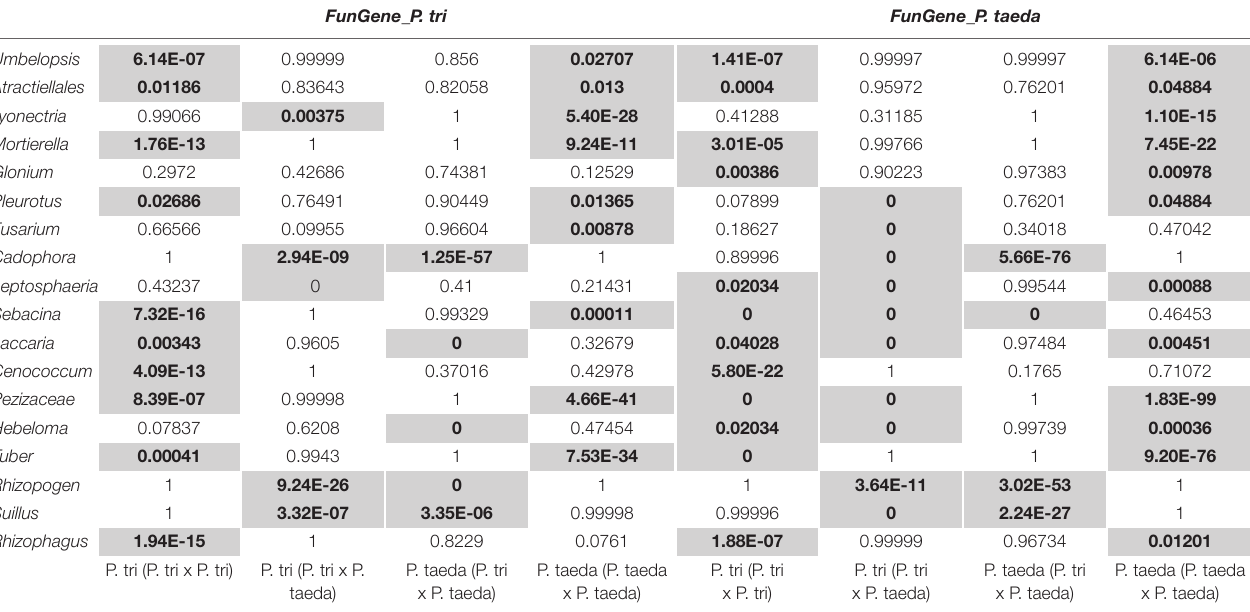
TABLE 1 | Hypergeometric test was performed to identify the enrichment of the functional genes of top fungal taxa in associated with neighboring plant traits. FunGene_P.